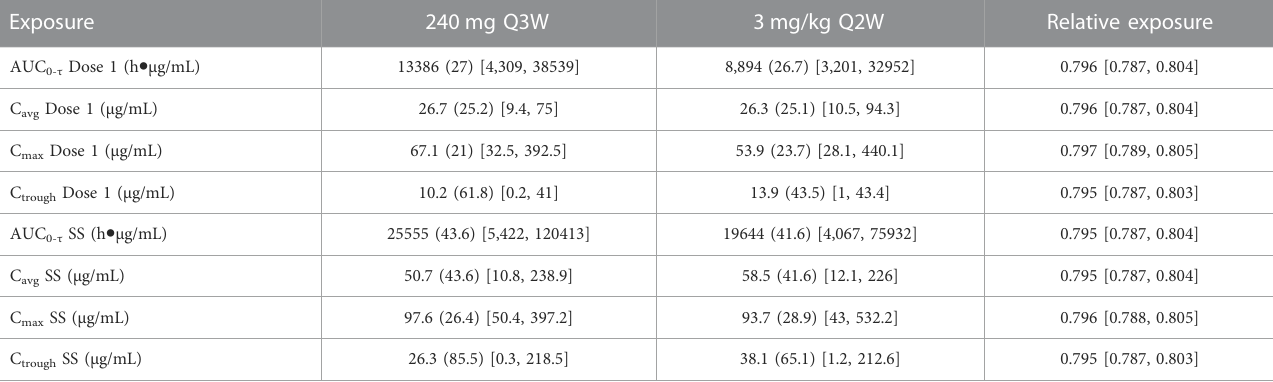
TABLE 2 Exposure comparison of toripalimab at 240 mg Q3W and 3 mg/kg Q2W.